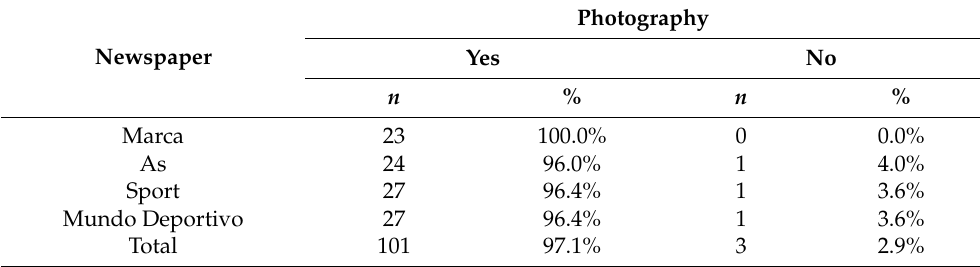
Table 8. Use of photography, depending upon newspaper. Compiled by